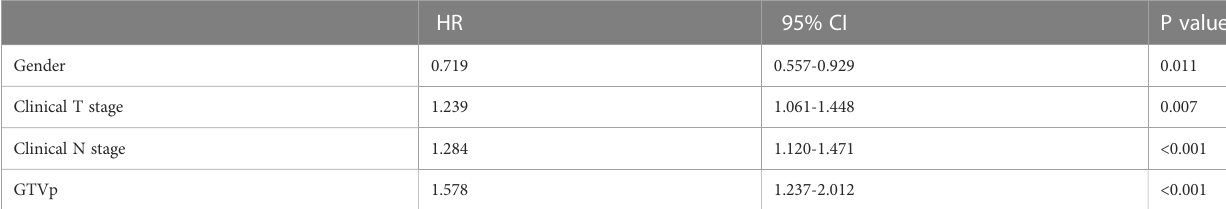
TABLE 2 Multivariable analysis of clinical variables to predict overall survival in the training